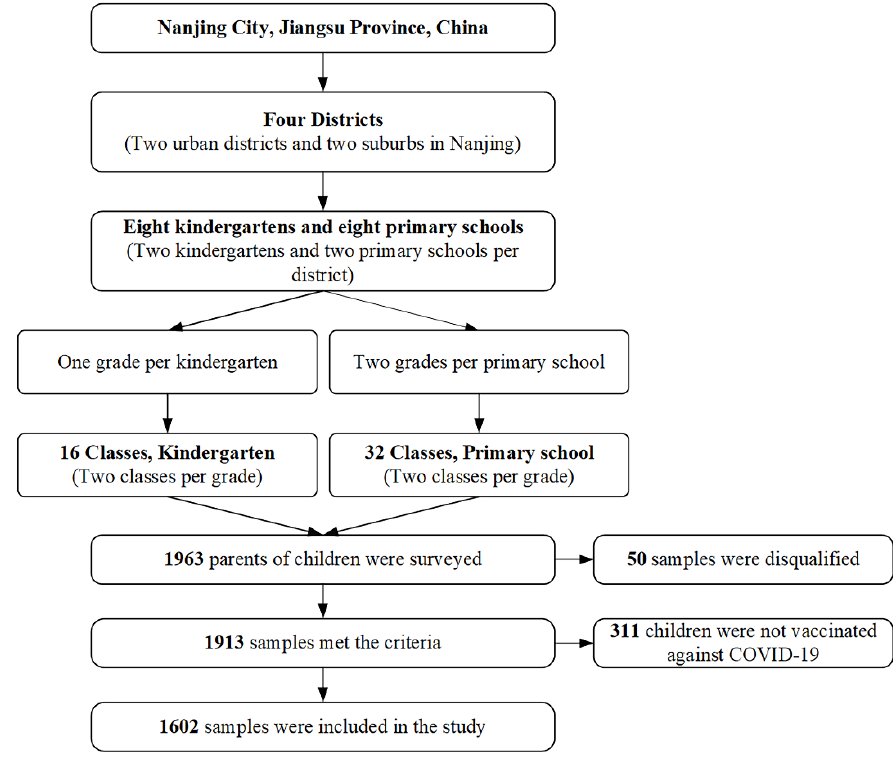
Figure 1. Flow chart of multistage stratified cluster sampling.